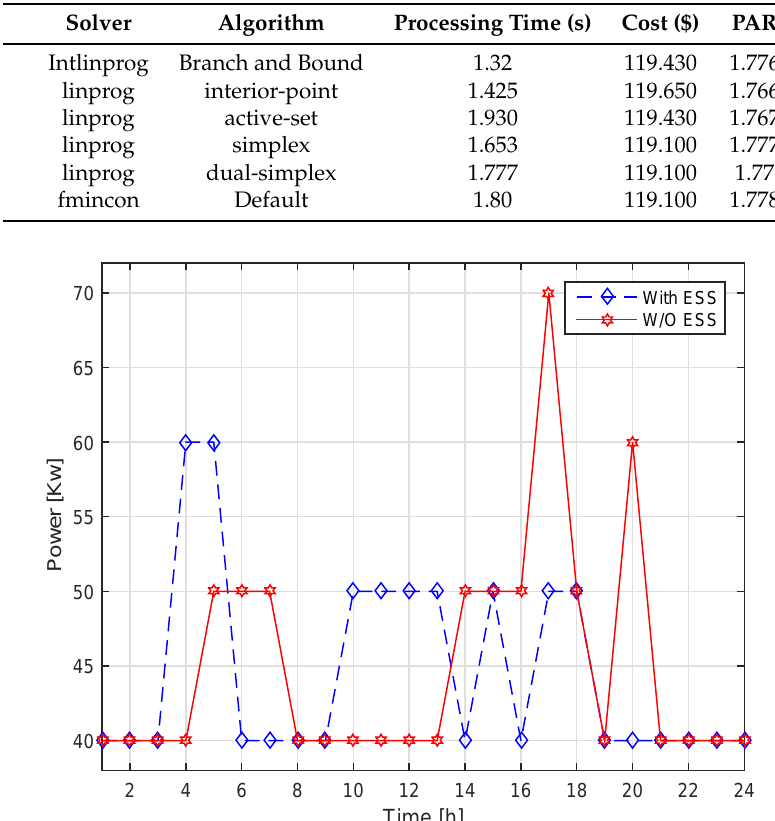
Table 2. Solvers Performance for single dwelling.